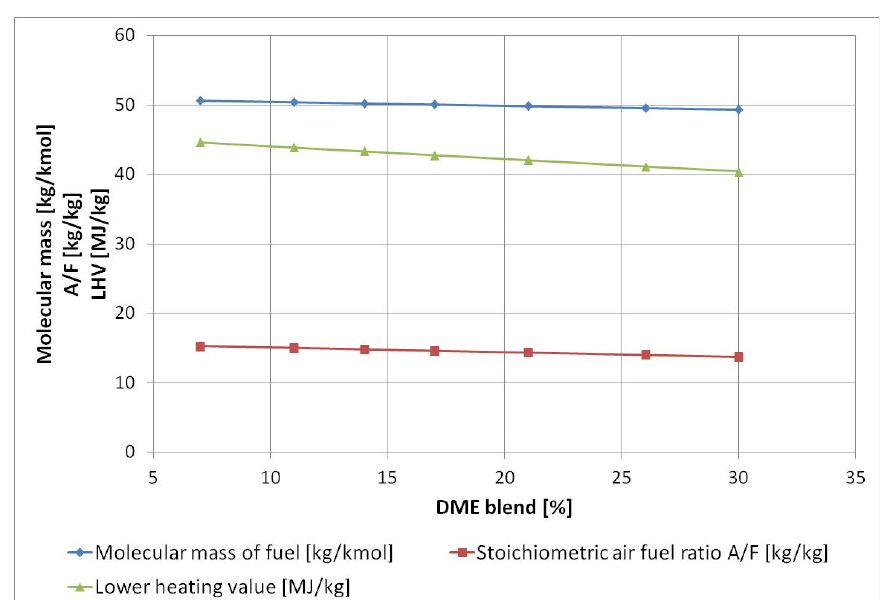
Figure 4. Influence of DME mass fraction on selected parameters characterizing the mixture. The parameters shown in Figures 4 and 5 were determined from the molar mass of each component, considering stoichiometric